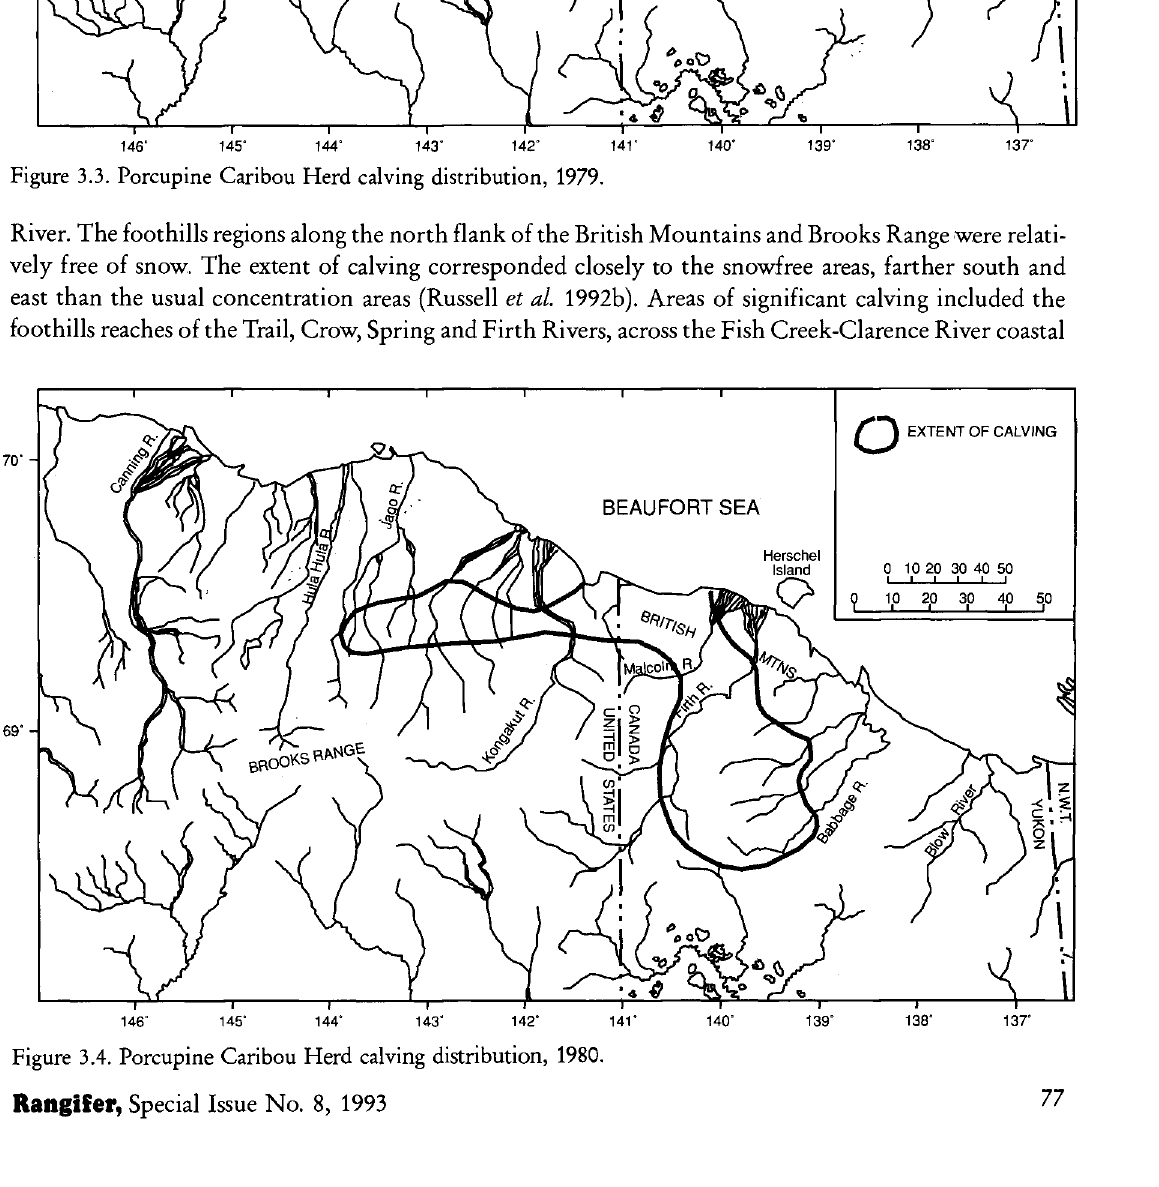
Figure 3.4. Porcupine Caribou Herd calving distribution,